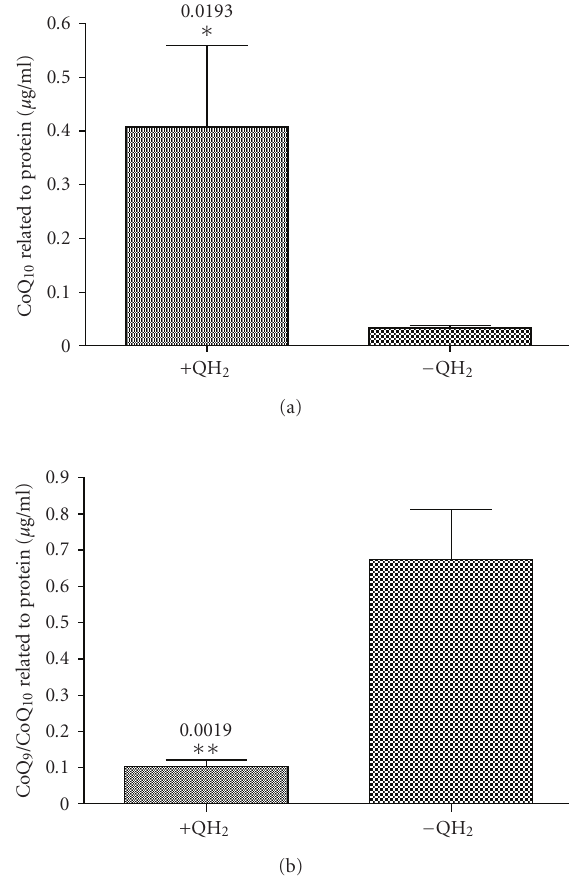
Figure 3: E ff ect of ubiquinol-10 concentration (a) on CoQ 10 levels and (b) the CoQ 9 /CoQ 10 ratio in liver tissues of mice. Mice were fed with ubiquinol-10 (250 mg/kg/d) or a respective control diet (no ubiquinol-10 supplement) for 7 days followed by a sublethal intraperitoneal injection with saline (0.9% NaCl, LPS negative control) for further 4hours. Thereafter, liver samples were collected, homogenized, and used for HPLC analysis with electrochemical detection. CoQ 9 was used as an internal standard. Observed CoQ levels were related to the corresponding protein levels of the respective liver homogenate samples (single data not shown). All data (one-sided t -test) are means ± SEM of 5 animals in the intervention group (+QH 2 ) and control group ( − QH 2 ), respectively. Protein-related CoQ 10 levels and CoQ 9 /CoQ 10 ratio of ubiquinol-10-supplemented and control animals are depicted in Figures 3(a) and 3(b),